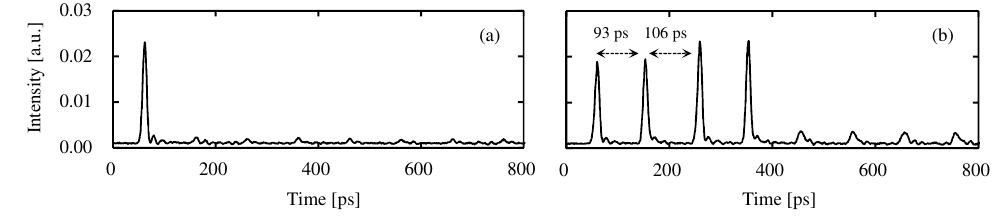
Figure 3. Impulse response of the 8-bit optical comparator: ( a ) Input pulse; ( b ) Output of optical comparator. In this figure, the impulse is separated into four parts, and four pulses are arranged at uniform intervals. The time intervals in each pulse offered 5.03 and 10.72 GHz of FSR in each